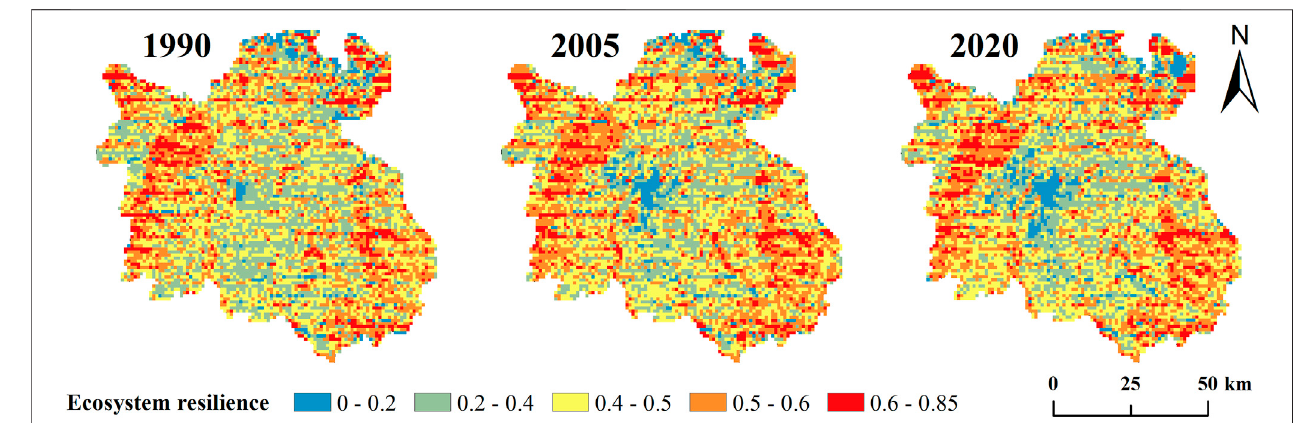
FIGURE 8 | Spatial distribution pattern of integrated ecosystem resilience in 1990, 2005, and 2020.